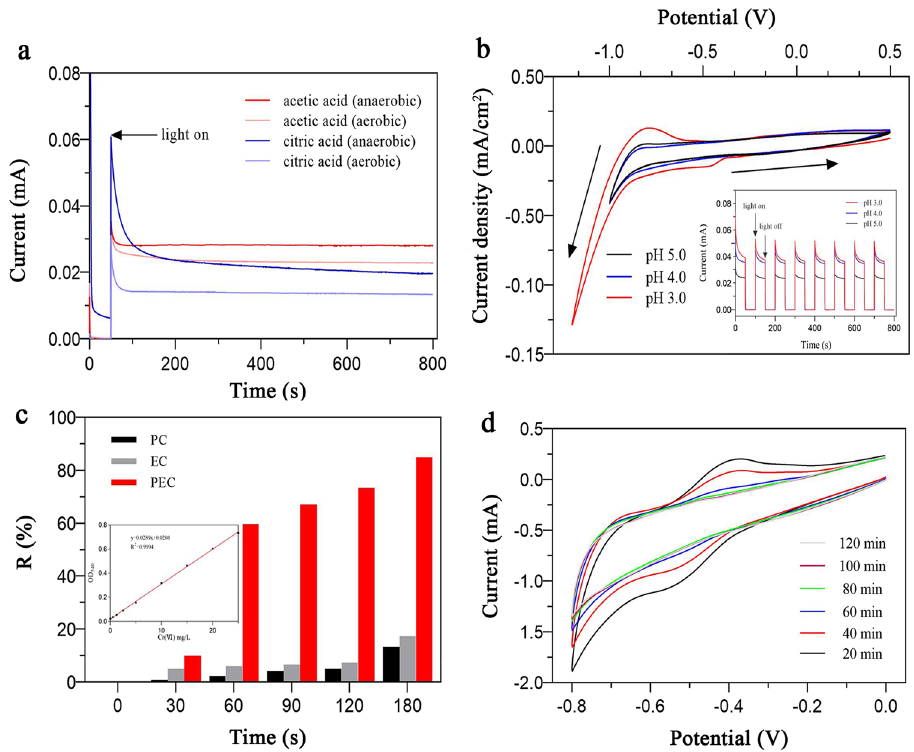
Fig. 5 a Effect of oxygen and organic acid on the i–t curve, b CV and transient photocur- rent measured at different